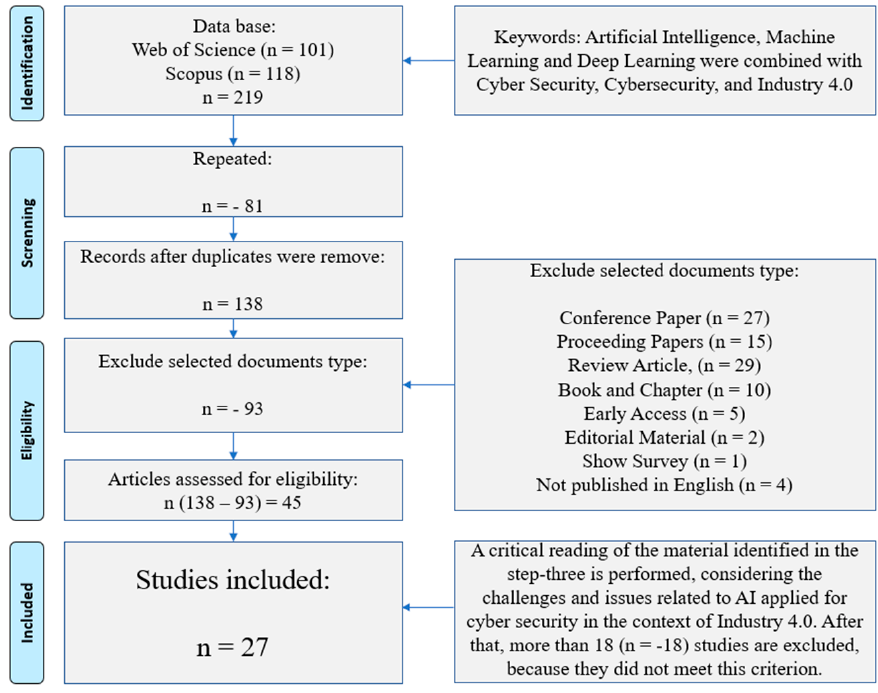
Figure 1. Prisma Flow. Table 2. Search